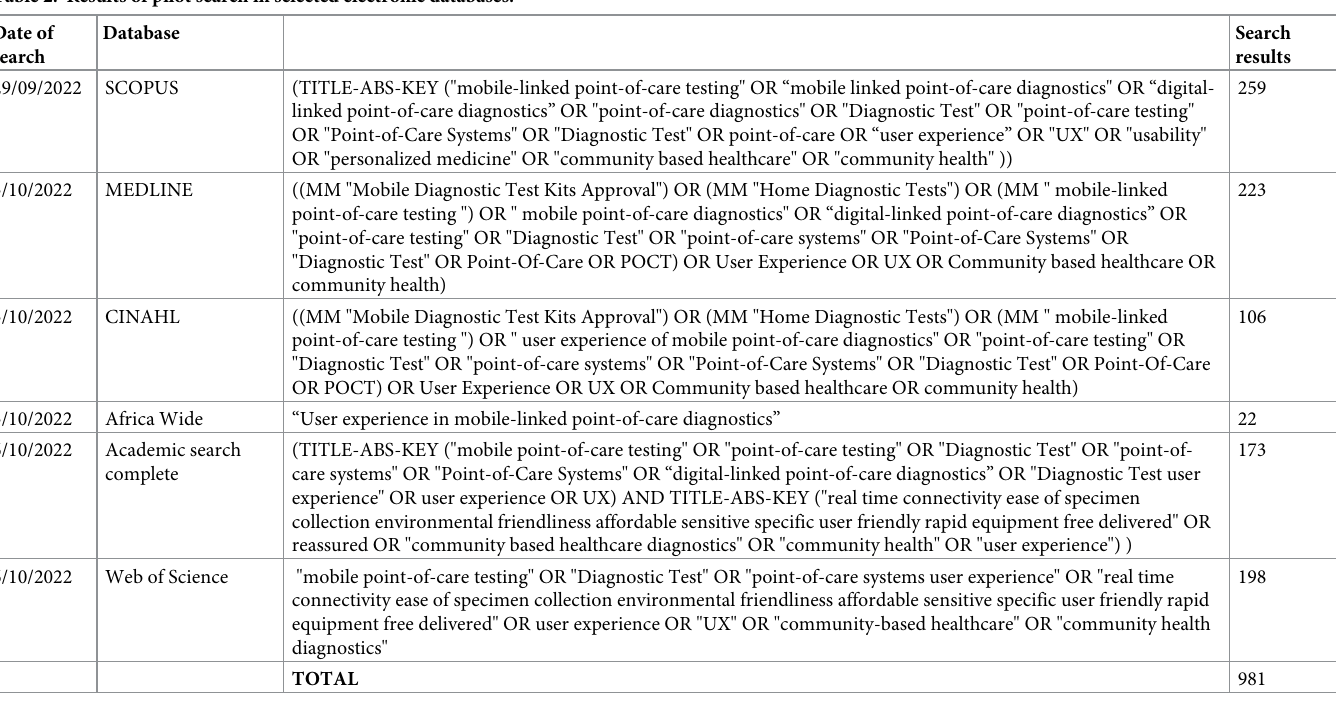
Table 2. Results of pilot search in selected electronic